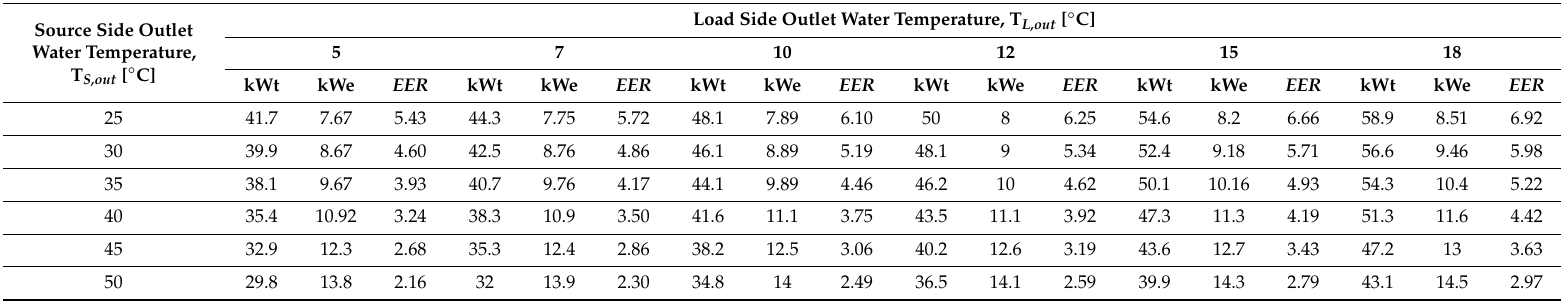
Table 1. Manufacturer data for reversible heat pump. The data are from Clivet manufacturer for HP model WSHN-XEE2 MF 14.2. Cooling Mode. Source Side Outlet Water Temperature,